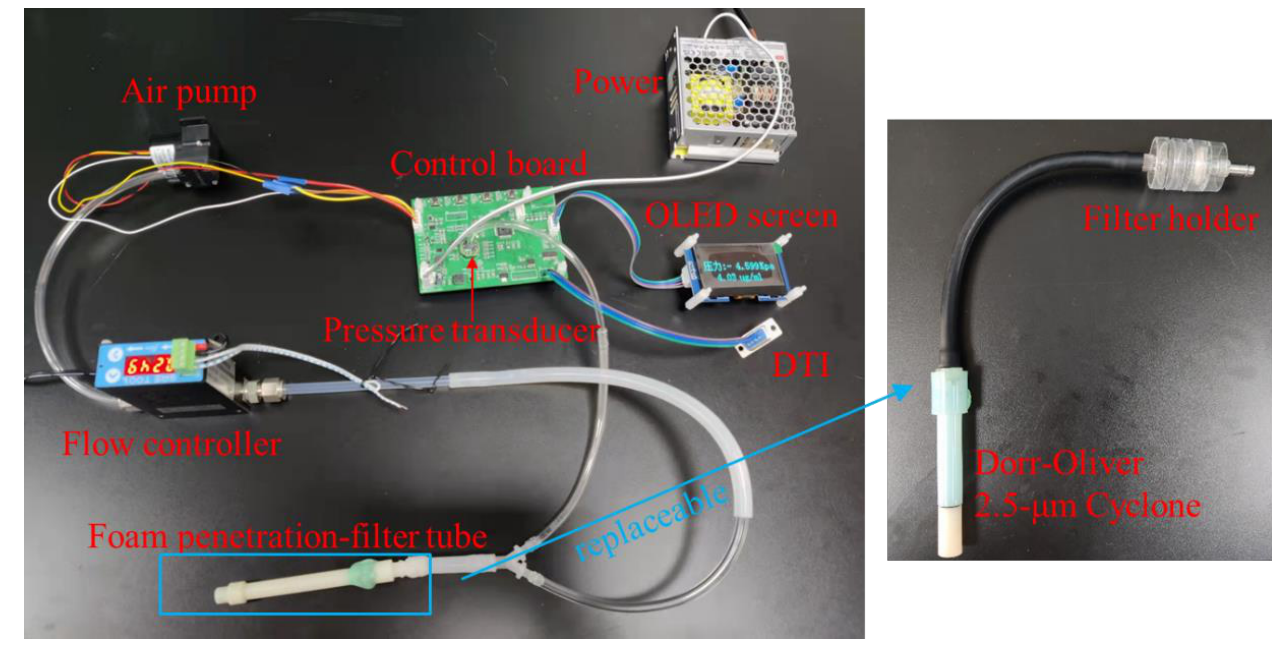
Figure 1. Pressure-based PM 2 . 5 monitor.